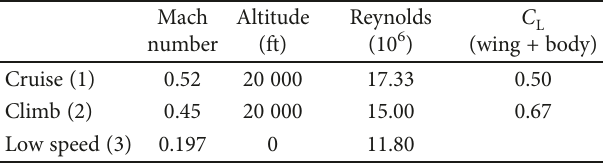
(b) After chimera preprocessing: masked cells are blanked Figure 3: Example of chimera grids used for 2D. Table 2: Range in local C coe ffi cients considered for the airfoil L multipoint